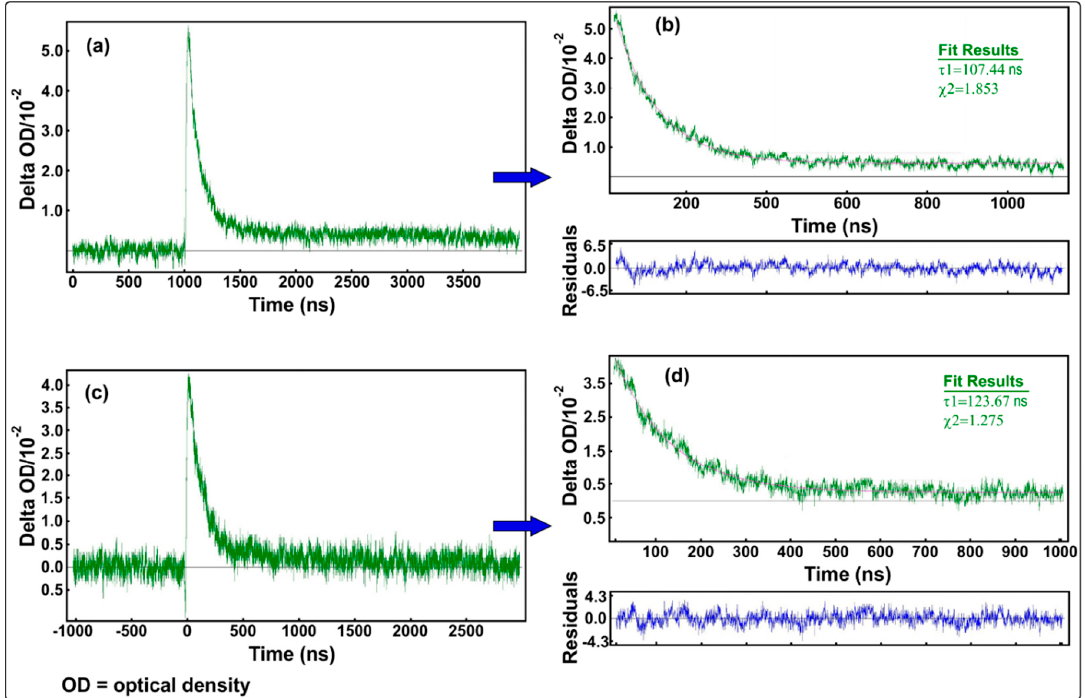
Figure 10. Kinetics transient absorption decay and exponential fitting for ZnO:MoO 3 (S3) ( a , b ) and ZnO:MoO 3 (S5) ( c , d ) samples, upon excitation at 372 nm.